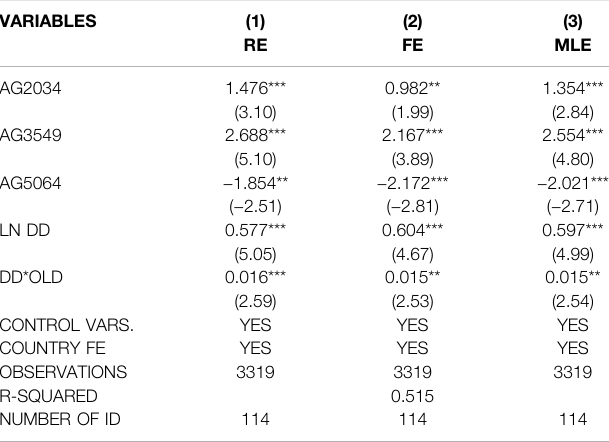
TABLE 5 | The interaction effects of degree-days and population aging on electricity carbon emission